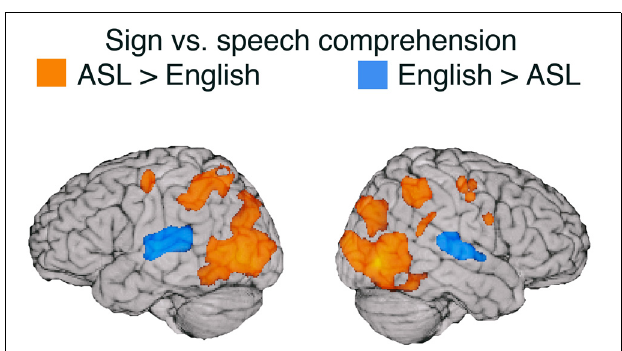
FIGURE 2 | Illustration of the contrast (thresholded at q = 0 . 001) between signed and spoken language comprehension overlaid on an individual human brain. Regions more active for spoken language comprehension (indicated in blue) include superior temporal gyrus in both hemispheres. Regions more active for signed language comprehension (in orange) include bilateral middle occipital cortex, bilateral pre-central gyrus, bilateral post central gyrus, bilateral IPS, left SPL, left SMG, and right pSTG. Up to 30mm beneath the surface of cortex is displayed on the contrast